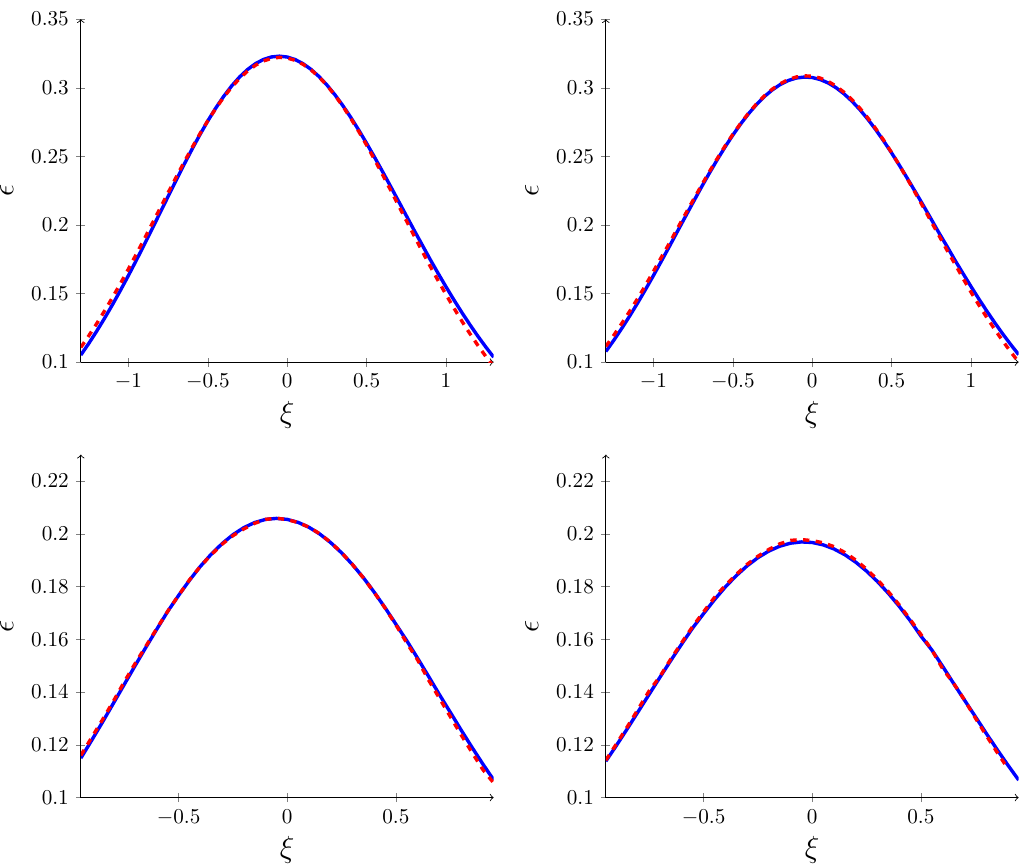
Figure 7 . The proper energy density (cid:15) as a function of rapidity (cid:24) at constant proper time (cid:28) = 2 ((cid:12)rst row) and (cid:28) = 3 (second row) for asymmetric collisions with ( w ( w ; w (cid:0) ) = (0 : 075 ; 0 : 25) (right) displayed as the solid blue curves. On each plot, the red dashed + curve shows the geometric mean of the corresponding symmetric distributions shifted by (cid:22) (cid:24) as given in eq. (4.7). Only at j (cid:24) j & 1 is a slight deviation between the two visible.